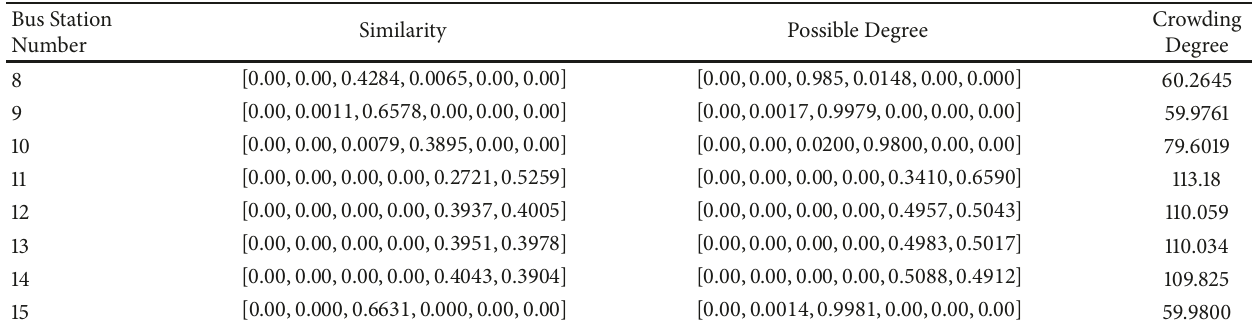
Table 11: Similarity, possibility degree, and crowding degree of the selected bus